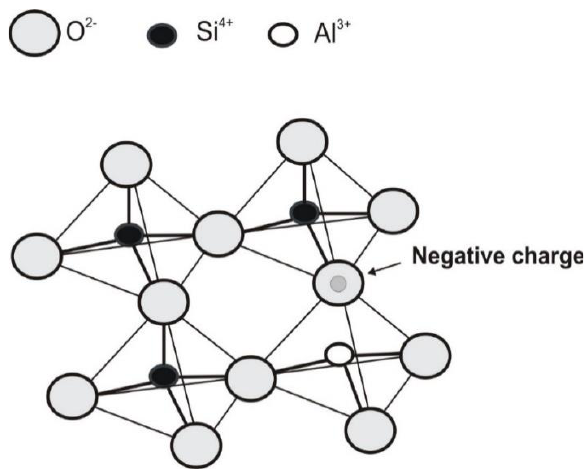
Figure 3. Zeolite framework of tetrahedral [SiO4]4- (adapted from [59,60]). Table 1. Properties of some commonly available synthetic zeolite formed from fly ash.